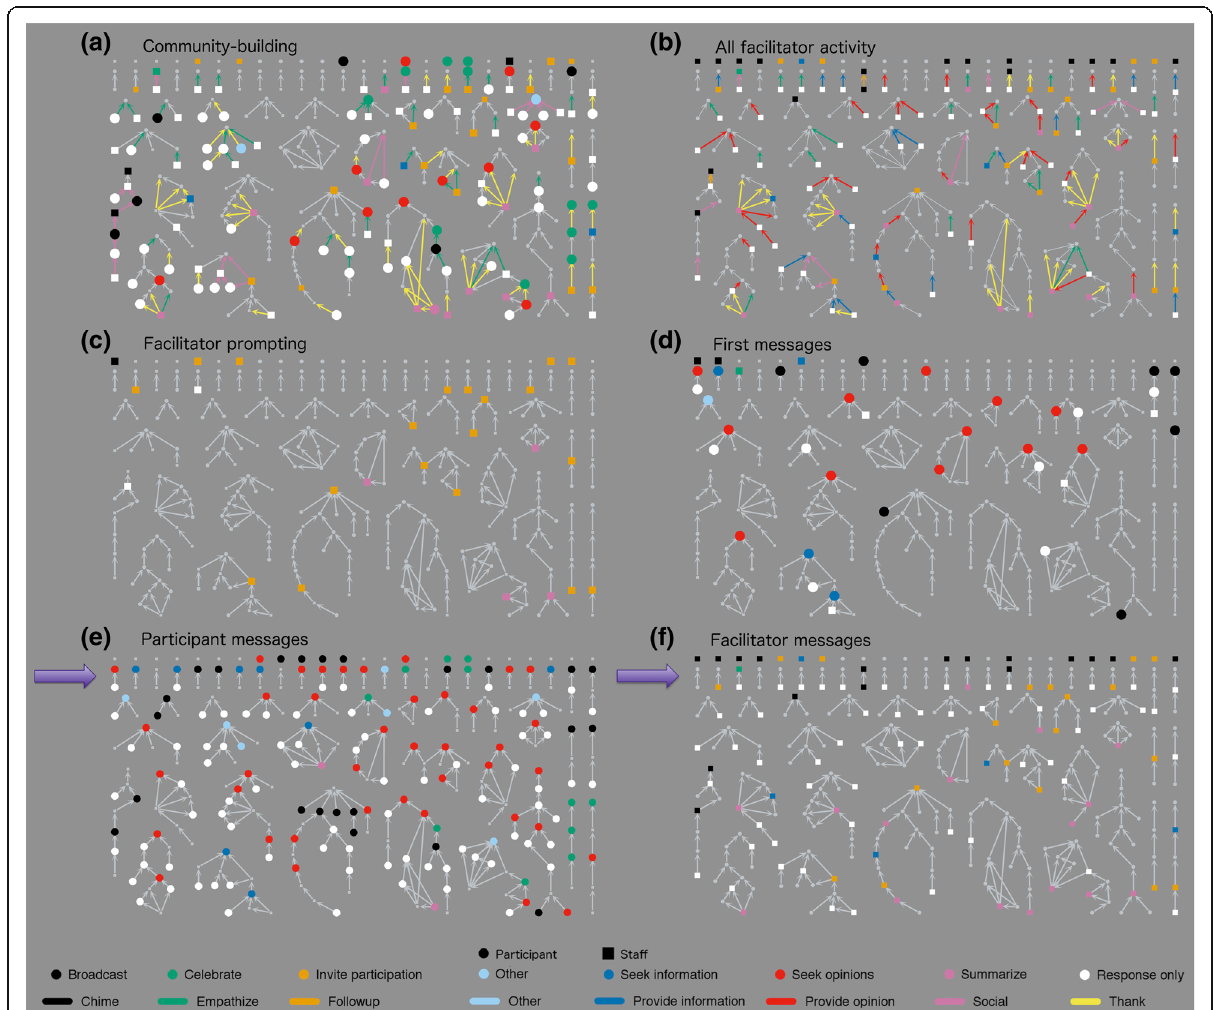
Fig. 9 a – f Network diagrams highlighting ancillary functions and sender